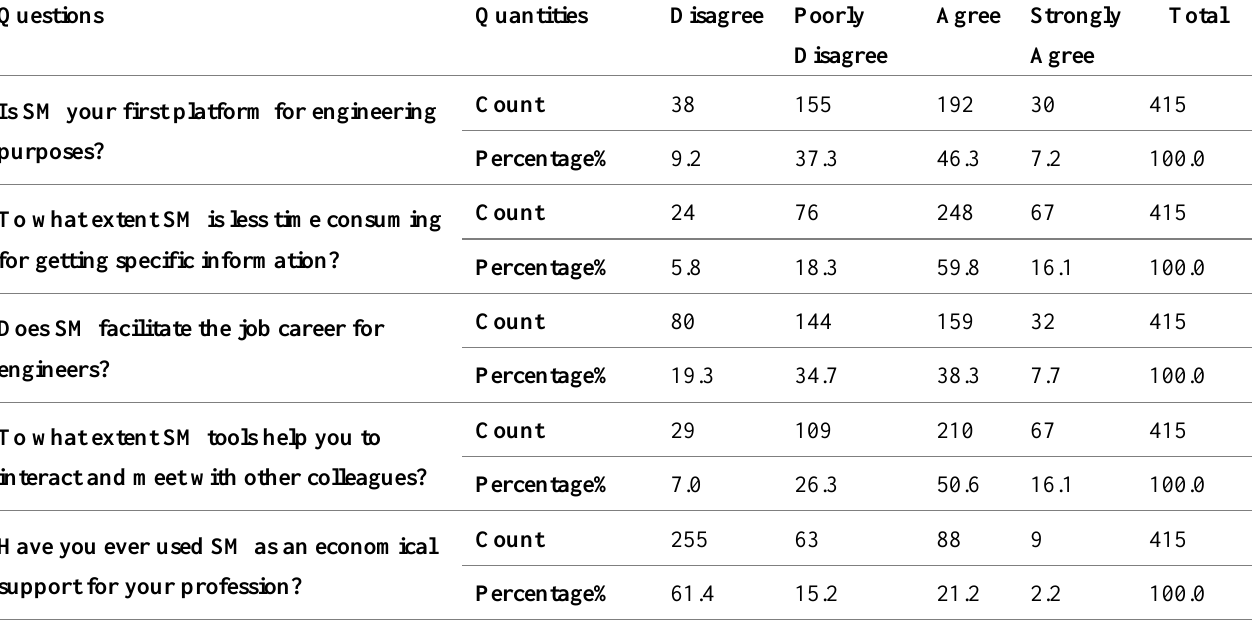
Table 5. Analysis of Likert Scale